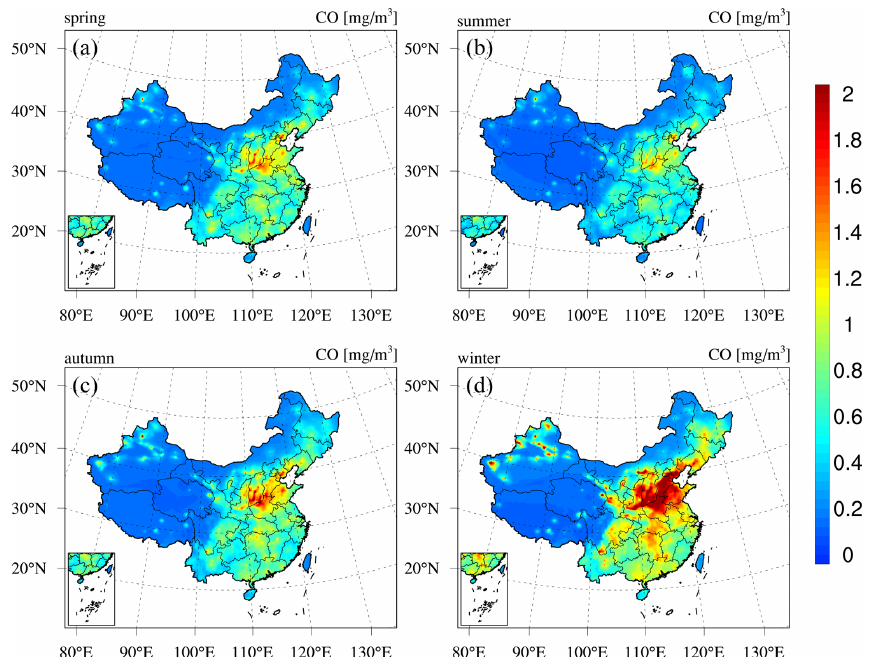
Figure D4. Same as Fig. D1 but for CO.